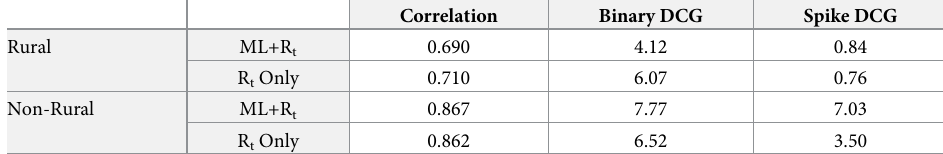
Table 2. A comparison correlation of 7-day positive case totals and 7-day actual case, and both DCG metrics (total) for the ML+R t methods implemented when viewed by rural and non-rural counties.